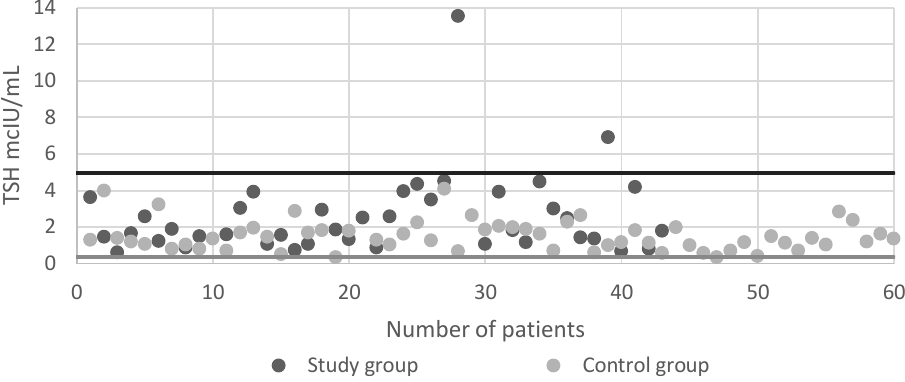
Figure 2. The TSH concentration in the study group and in the control group.